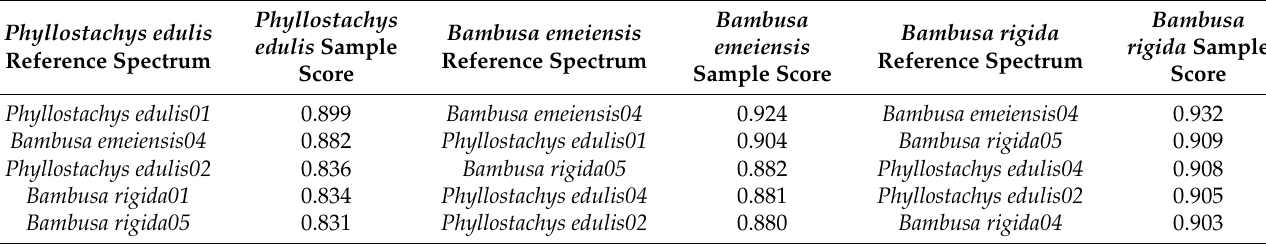
Table 3. The “angle” score of the reference spectrum and the reference sample spectrum.